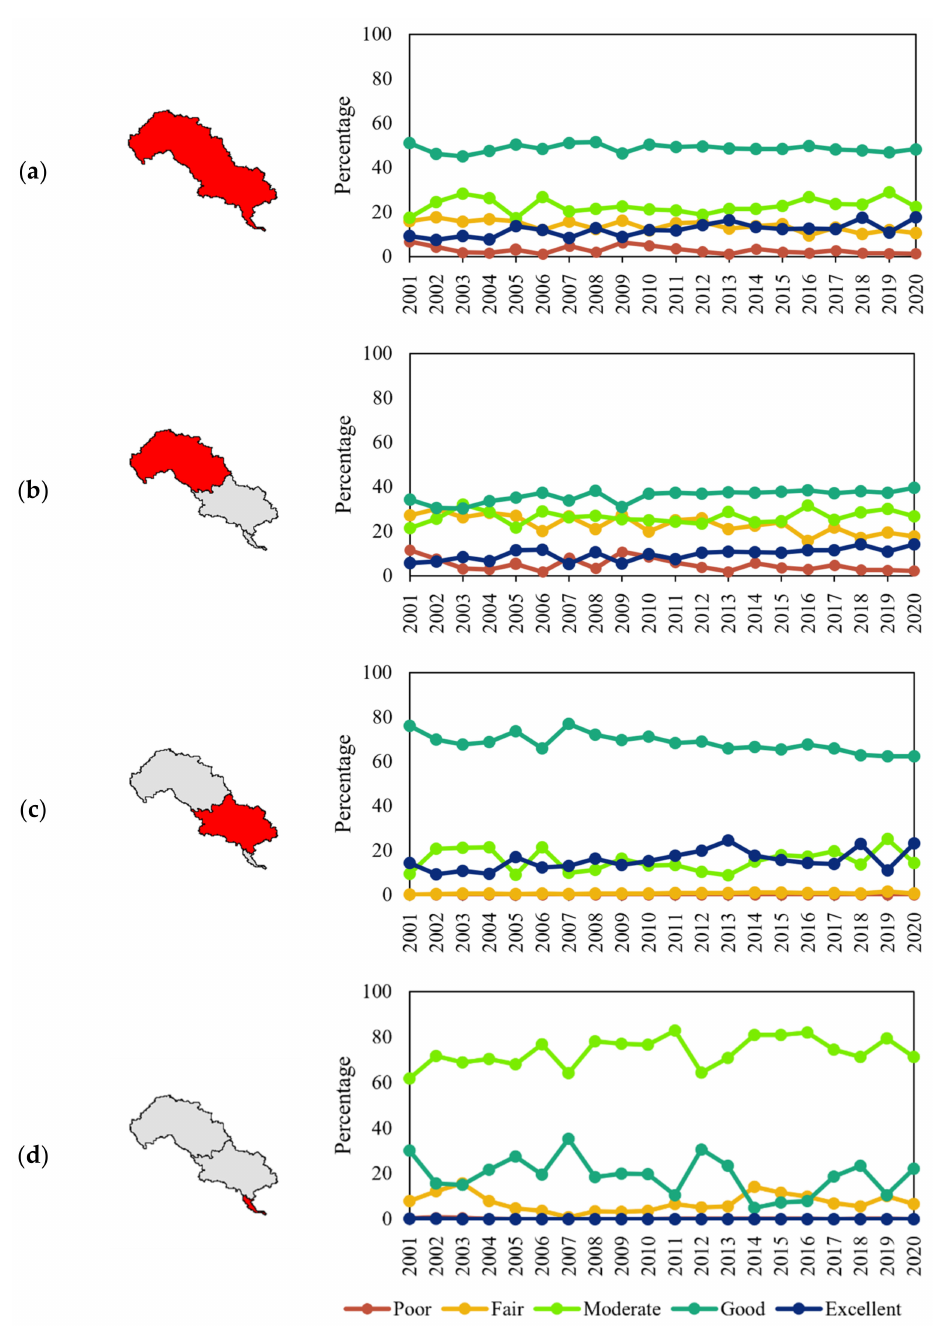
Figure 5. Proportions of different levels in time series ( a ) LHRB, ( b ) upper reaches, ( c ) middle reaches, ( d ) lower